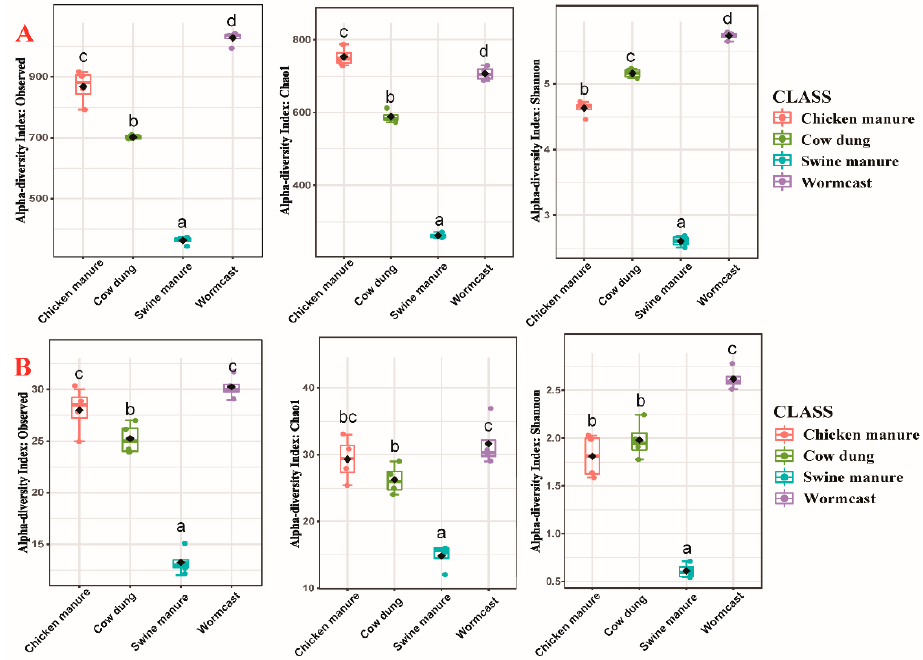
Figure 1. α -diversity of bacteria ( A ) and myxobacteria ( B ) communities in four compost manures. The lowercase letters (a–d) above the box represent significant differences ( p < 0.05) between the α -diversity at different compost manures.